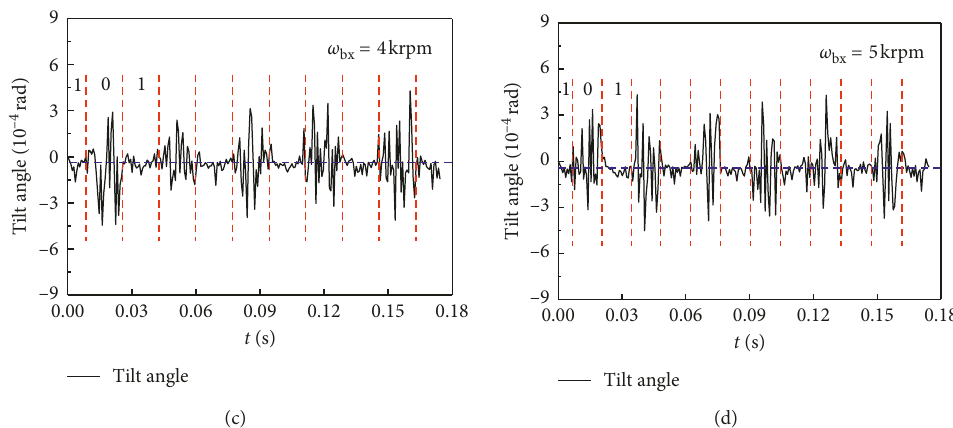
Figure 6: The tilt angle of the conical roller. 1: loaded zone; 0: unloaded zone. F